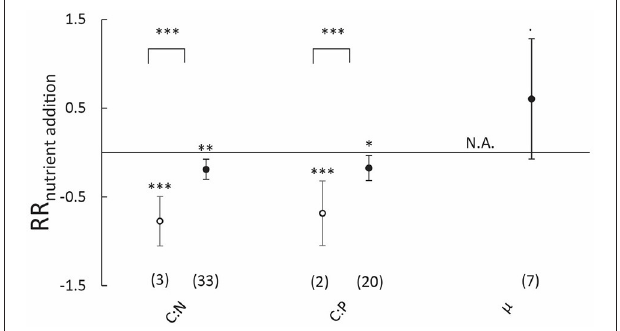
FIGURE 6 | Natural-log response ratios of aboveground carbon:nutrient stoichiometry and growth rates ( µ ) to nutrient (nitrogen and phosphorus) addition in freshwater (open circles) and marine (closed circles) submerged aquatic plants. Values represent means, error bars 95% confidence intervals and sample size is indicated between brackets. Significance levels are indicated as follows: *** P < 0.001, ** P < 0.01, * P < 0.05 and · P < 0.10. N.A., indicates that data were not